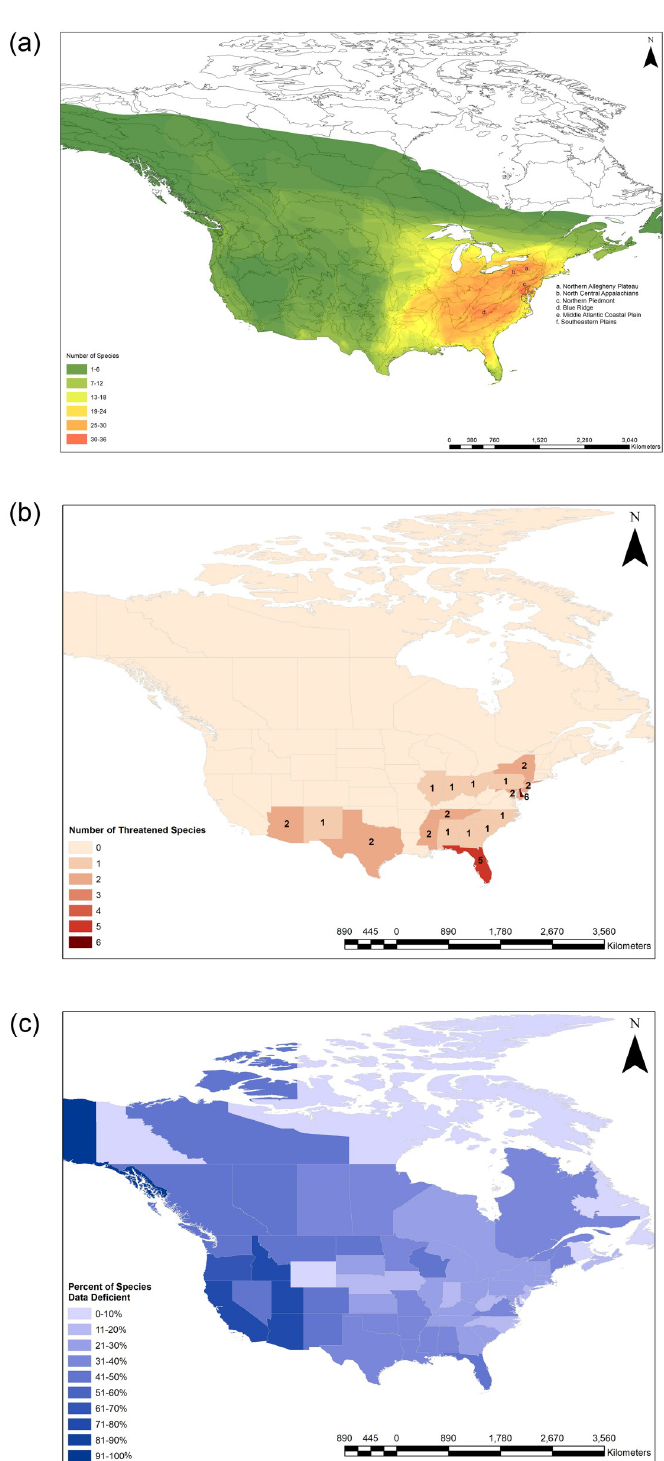
Fig 3. Species distributions and status summaries. (A) Overall species richness of fireflies in the U.S. and Canada. Gray lines indicate Level III Ecoregion boundaries. Ecoregions with the highest species richness are labeled; all others are unlabeled. (B) Geographic summary of threatened (CR, EN, or VU) firefly species. Note that one of the taxa indicated in Arizona consists of 2 subspecies that are also threatened. (C) Geographic summary of Data Deficient firefly species, shown as a percent of the total number of species reported from each state. The maps were created by